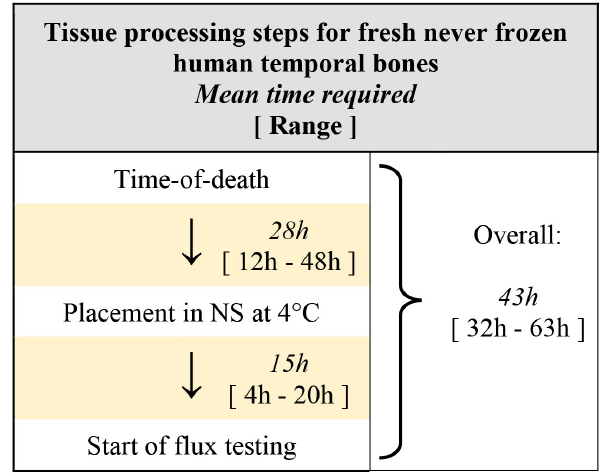
TABLE 1 | Timing for tissue processing steps, from time-of-death to start of flux testing.